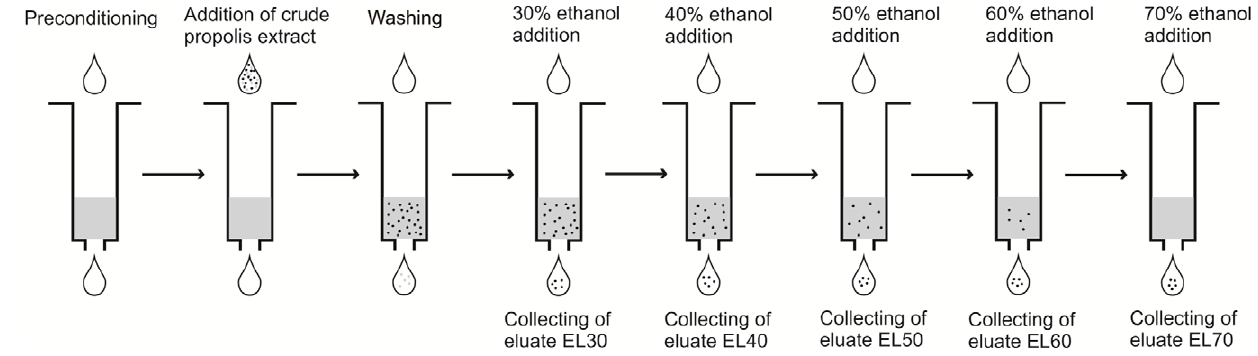
Figure 1. Preparation of the EL30 to EL70 eluates from the crude propolis extract by solid-phase extraction.